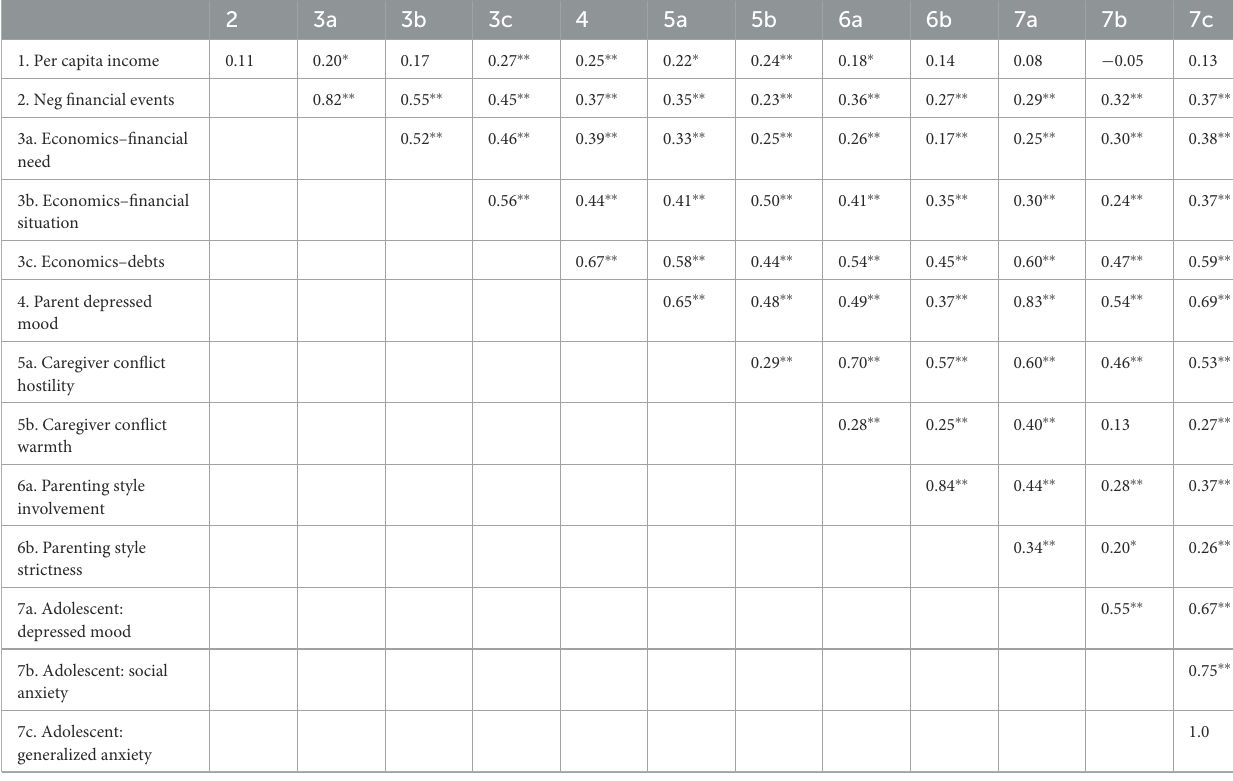
TABLE 6 Matrix of Pearson correlation coefficients among indicators of the Family Stress Model ( N =